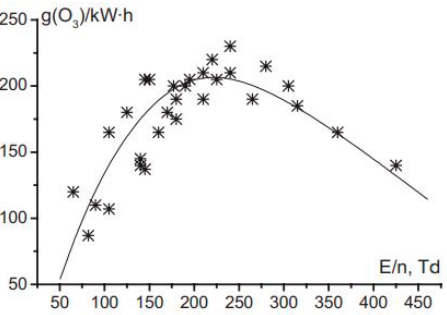
Figure 3. Schematic diagram representing the formation of various reactive species in the plasma phase, in the gas phase, in the interfacial region, and below the interfacial region during plasma irradiation of a target.